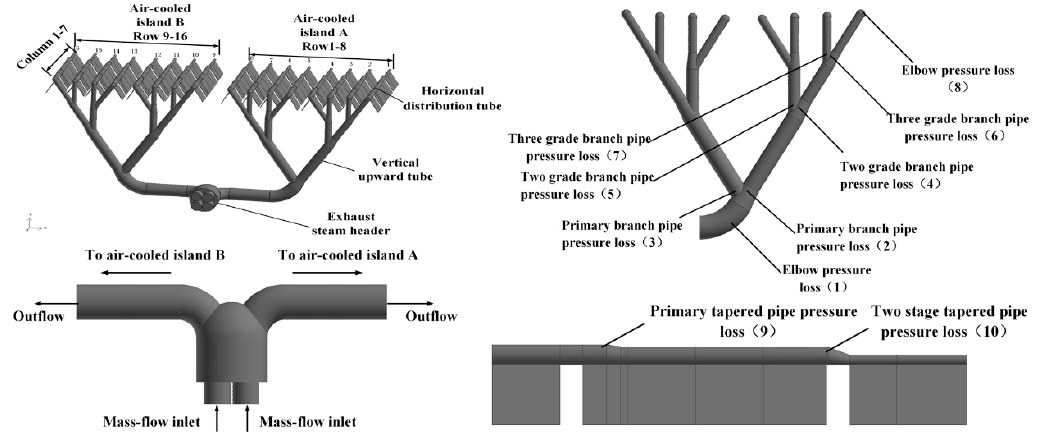
Figure 2. The piping-main arrangement air-cooled system of the co-established power generating units.